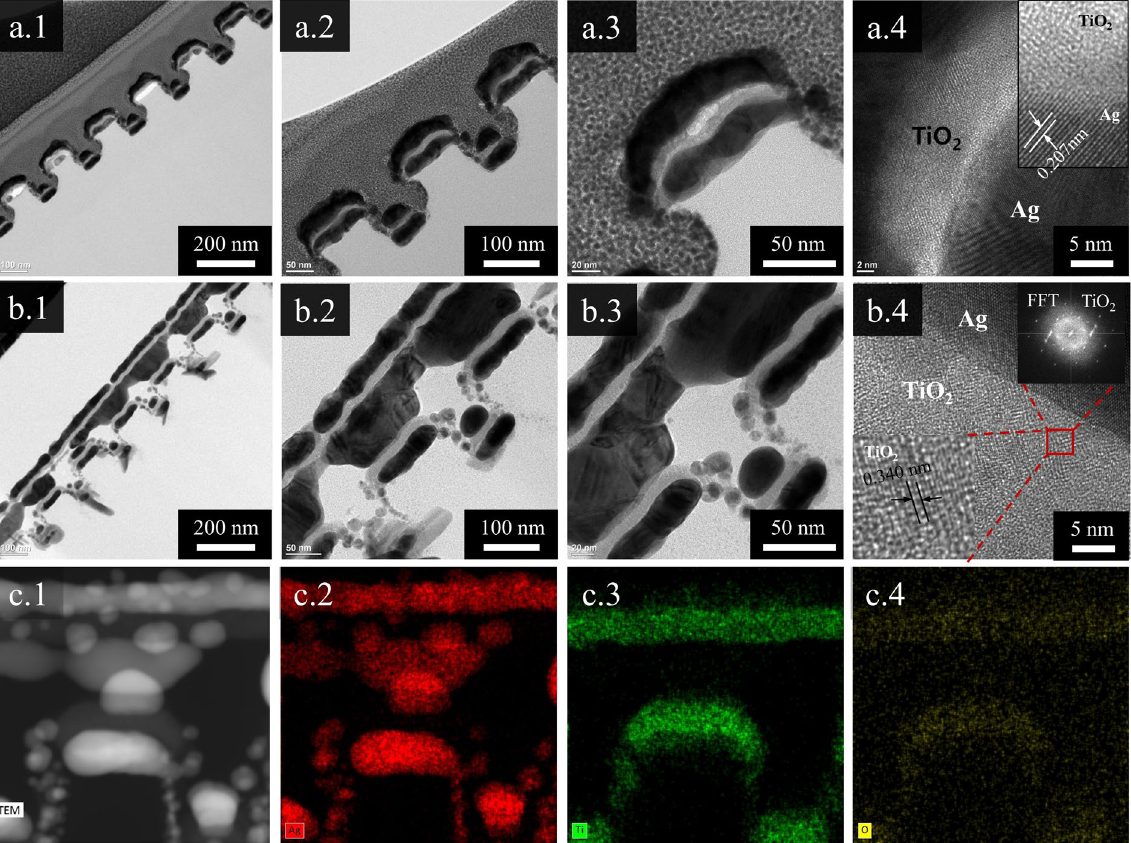
Figure 4. ( a . 1 , a . 2 , and a . 3 ) cross-sectional TEM images of Ag/TiO 2 nanocomposite wires, ( a . 4 ) high- resolution TEM images in the Ag and TiO 2 layers (inset: crystallinity of Ag and TiO 2 , scale: 1 nm); ( b . 1 , b . 2 , and b . 3 ) cross-sectional TEM image of two-layer Ag/TiO 2 nanocomposite cross architecture, ( b . 4 ) high-resolution TEM image of Ag and TiO 2 layers (insets: crystallinity and FFT image of TiO 2 ). ( c . 1 – 4 ) TEM image of Ag/TiO 2 nanocomposite cross architecture and the corresponding EDS mapping images of Ag, Ti, and O, in that